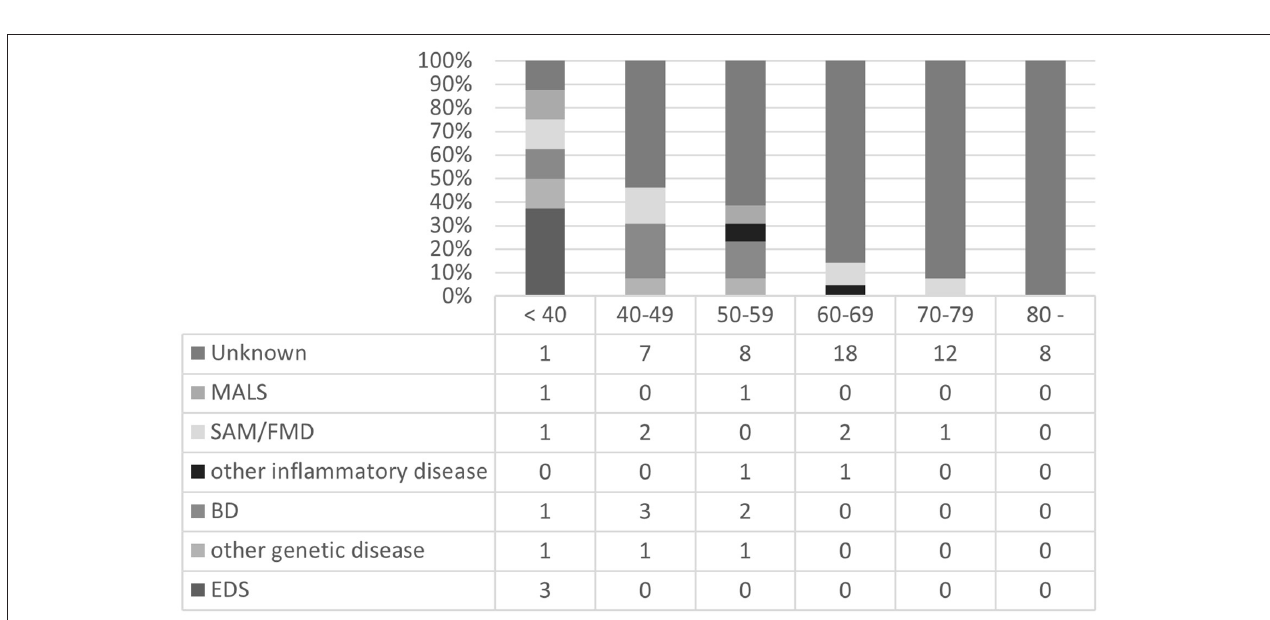
FIGURE 2 | Backgrounds or etiologies of patients with multiple arterial lesions ( ≥ 3) in each age group. MALS, median arcuate ligament compression syndrome; SAM, segmental arterial mediolysis; FMD, fibromuscular dysplasia; BD, Behçet’s disease; EDS, Ehlers-Danlos syndrome.